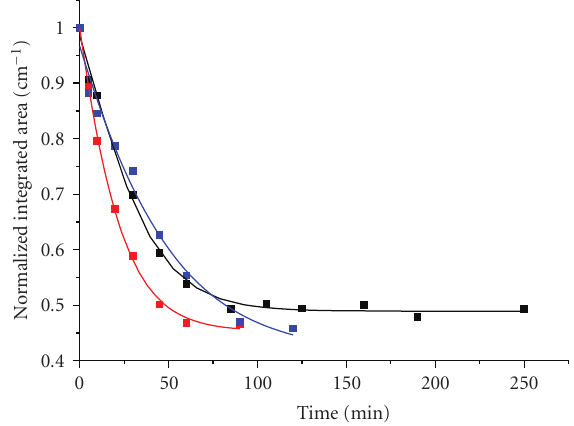
Figure 5: Repeated addition of stearic acid on a single Ag sample (2 passes). First stearic acid run , additional stearic acid added, and the experiment repeated once , twice .